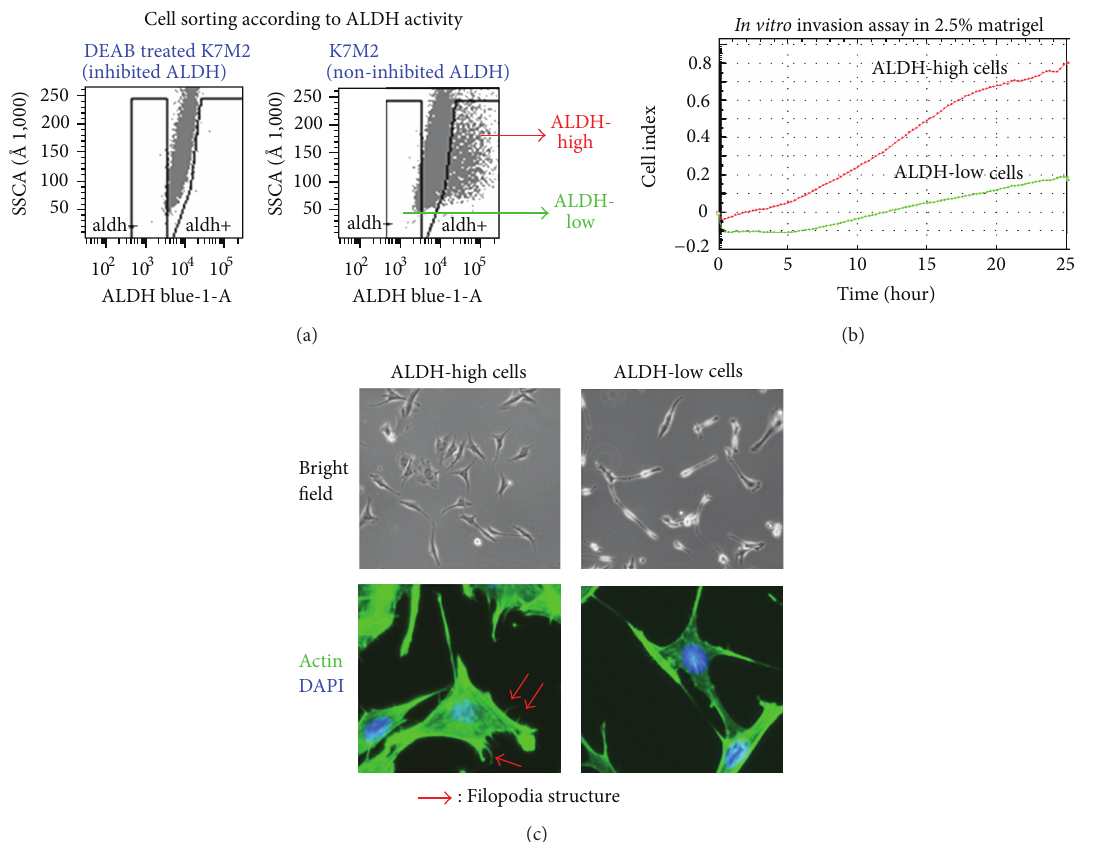
Figure 5: Cell sorting of K7M2 cells via ALDH activity and differential features of ALDH-high cells and ALDH-low cells. (a) K7M2 cells were suspended in Aldefluor buffer and sorted according to their fluorescence. Cells were treated with DEAB to block ALDH fluorescence, and cells were deemed ALDH-high if their fluorescence was higher than that of the DEAB-treated controls. Cells were deemed ALDH-low if their fluorescence was lower than that of the DEAB-treated controls. (b) ALDH-high and ALDH-low K7M2 cell invasion was tracked over a period of 24 hours and the data obtained is displayed. The ALDH-high cells displayed a much higher invasion potential, with more fraction of cells invading through the matrigel (2.5%). (c) Under bright field microscopy and under fluorescent microscopy (after staining for actin (green) and nucleic acids (blue)) ALDH-high K7M2 cells displayed more filopodia than ALDH-low cells. Also the ALDH-high cells were more irregularly shaped and were more pleomorphic than ALDH-low K7M2